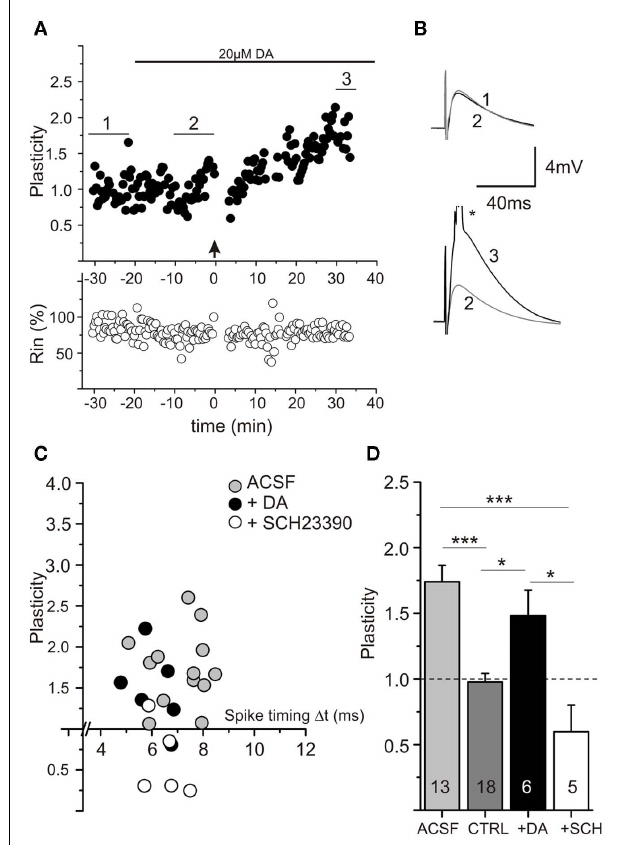
FIGURE 8 | Spike timing-dependent plasticity (STDP) inACSF prepared slices is dependent on endogenous dopamine. Experimental conditions as in Figure 6 . (A) Experiment showing unaltered STDP in an ACSF prepared slice after acute application of exogenous DA (20 μ M, see horizontal bar). (B) Averaged original traces [*suprathreshold EPSP is truncated; numbers refer to averaging intervals as indicated in (A) ]. (C) Data for STDP experiments in ACSF prepared slices performed either in normal ACSF (gray circles), in 20 μ M DA (black circles), or in the presence of the D1 antagonist SCH23390 (10 μ M; open circles). (D) Averaged data for experiments shown in (C) . Note that application of exogenous DA has no effect on intact STDP in ACSF prepared slices (with sufficient ambient DA), but that inhibiting D1 signaling by SCH23390 (SCH) significantly blocked potentiation at short positive pairings (white bar), CTRL = Control measurement without drug and pairing protocol (dark gray bar).* p < 0.05 or *** p < 0.001 ANOVA with post hoc Tukey